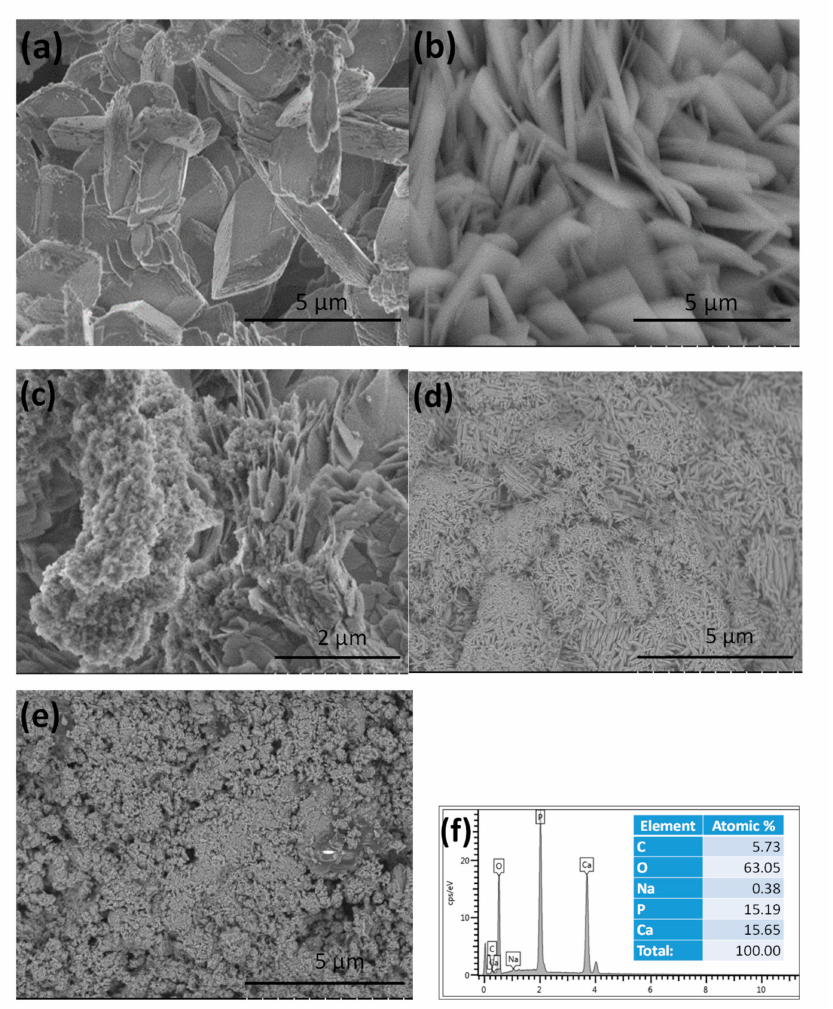
Figure 2. SEM images on CPC coatings prepared by di ff erent parameters. ( a ) t on : 5 ms, t o ff : 5 ms, i p : 0.4 A · cm − 2 , S1 sample. ( b ) t on : 5 ms, t o ff : 5 ms, i p : 1 A · cm − 2 , S2 sample. ( c ) t on : 1 ms, t o ff : 10 ms, i p : 5 A · cm − 2 , S3 sample. ( d ) S4: S3 sample after treatment in 1 M NaOH solution, ( e ) S5: S3 sample